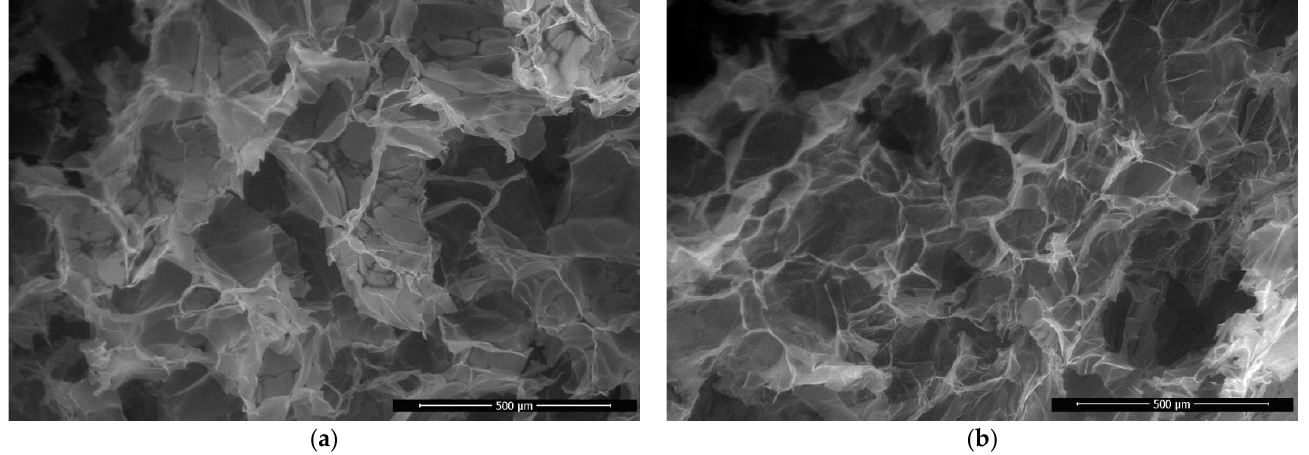
Figure 4. SEM images of fractures of the original chitosan aerogel ( a ) and chitosan aerogel modified with poly(GMA-co-HeMA) ( b ).